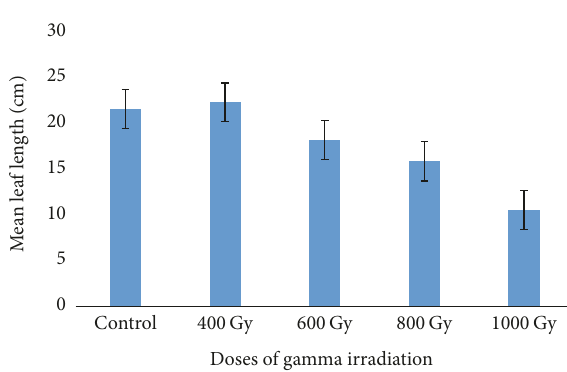
Figure 3: The effect of gamma irradiation doses on leaf length.